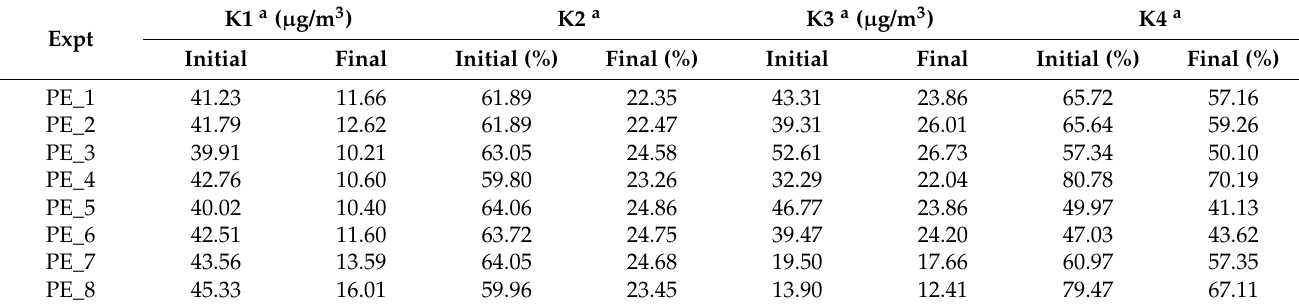
K1 a is MAGEs between the observations and the corresponding simulated PM 2.5 in interpolated samples. K2 a is MNGEs between the observations and the corresponding simulated PM 2.5 in interpolated samples. K3 a is MAGEs between the observations and the corresponding simulated PM 2.5 in checked samples. K4 a is MNGEs between the observations and the corresponding simulated PM 2.5 in checked